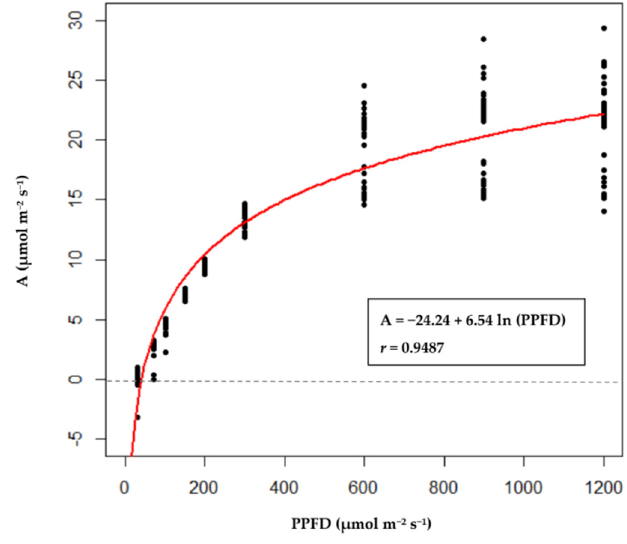
Figure 3. The light response curve of Rosada tomatoes. The points in the figure are actual observations,